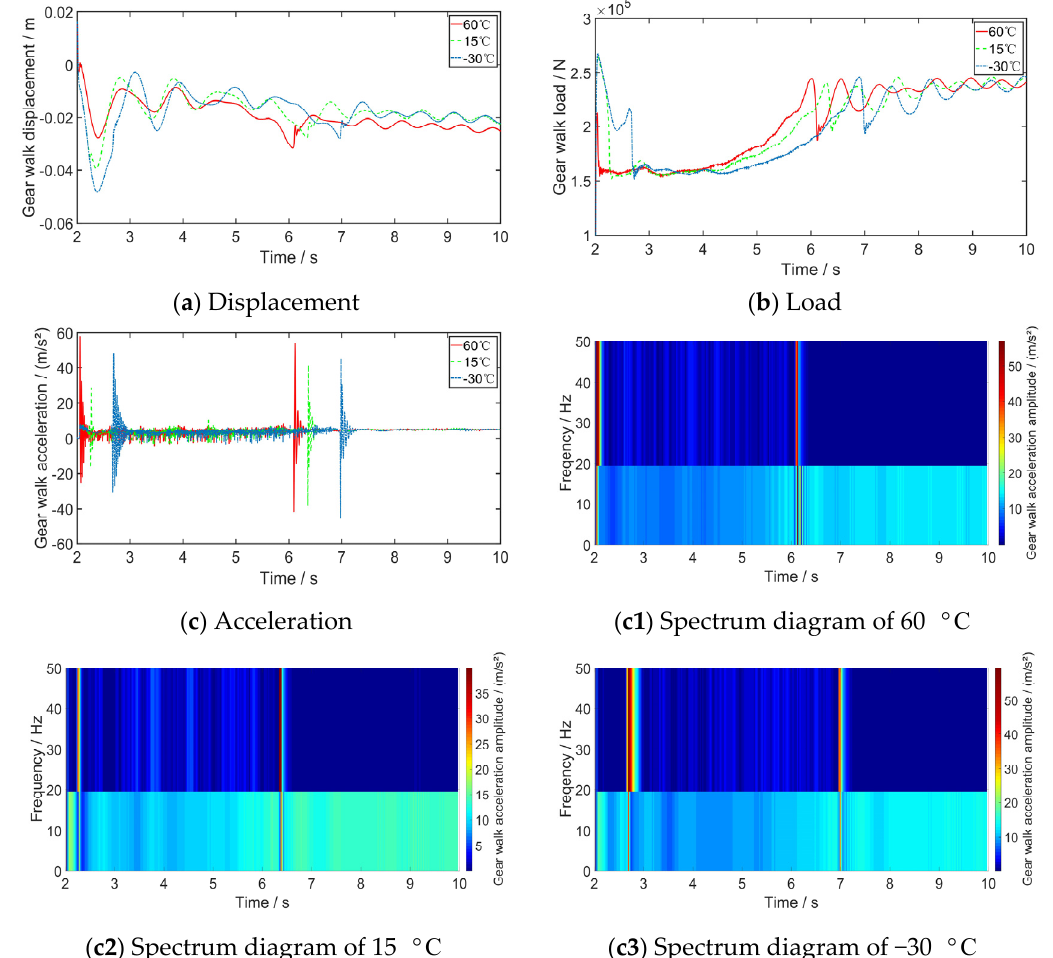
Figure 11. Effects of different ambient temperatures on gear walk.